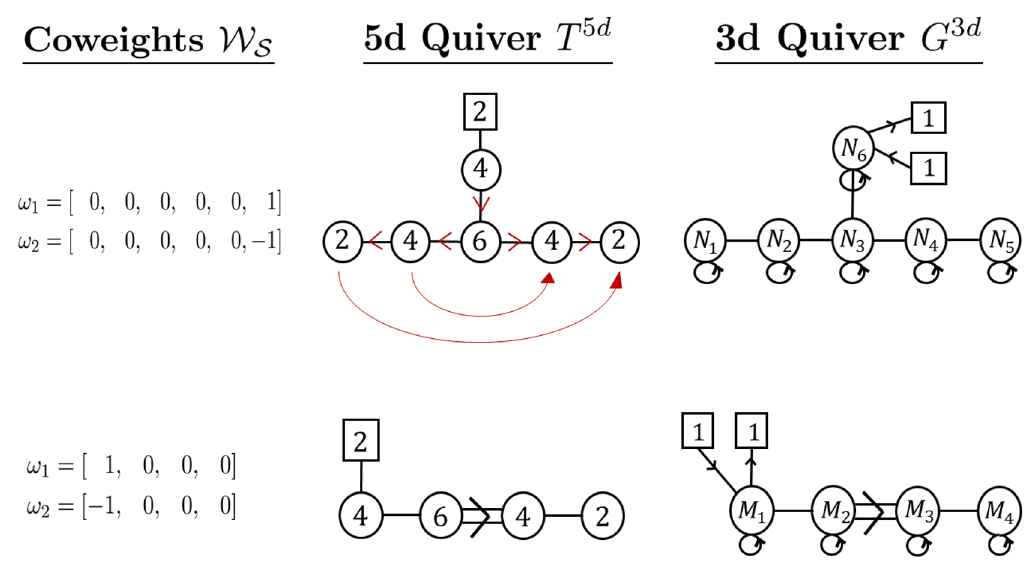
Figure 12. Folding of a E 6 little string defect and the resulting F 4 defect. The 3d theory at the triality locus is shown on the